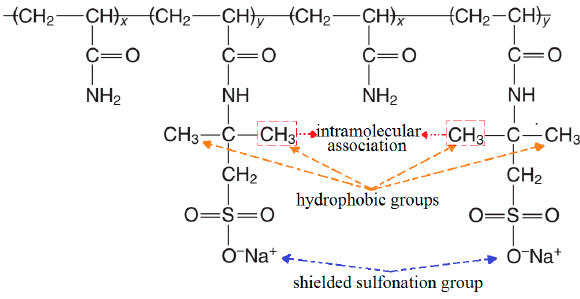
Figure 8. Hydrophobic groups association mechanism.